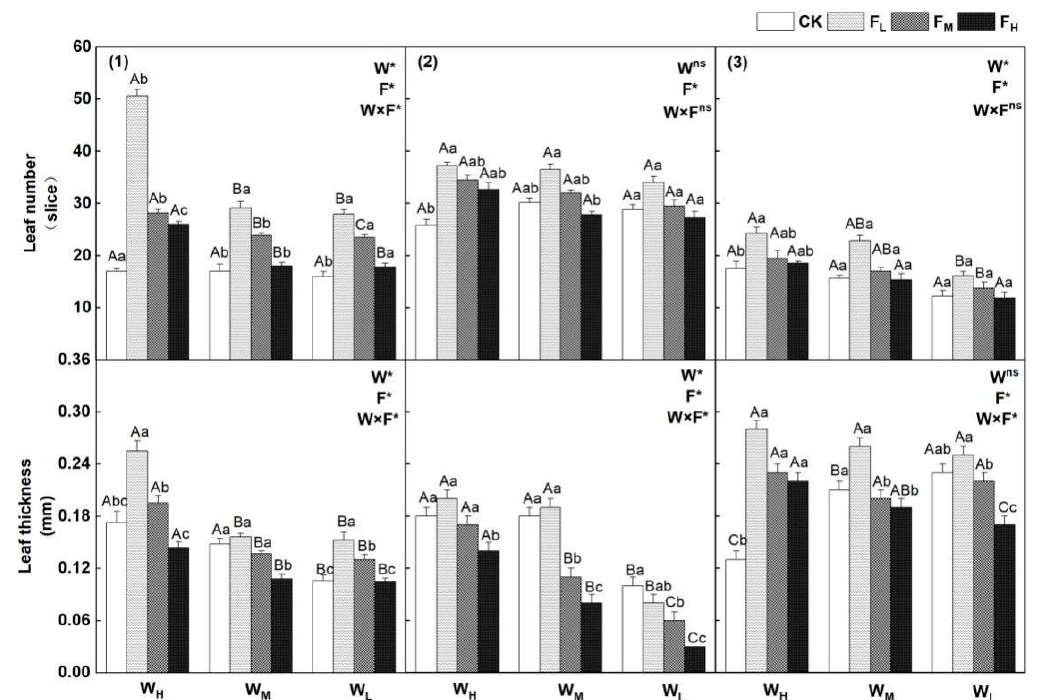
Figure 2. Changes in leaf number and leaf thickness values of test plant species under different water– fertilizer treatments. Numbers ( 1 ) − ( 3 ) in brackets indicate P. crymophila , F. coelestis , and S. purpurea , respectively. W, F, and W × F indicate the results of ANOVAs ( p < 0.05) for the effects of water, fertilizer, and their interactions. Asterisk (*) and ns indicate significant difference and non-significant. The uppercase letters and lowercase letters represent the difference between water and fertilizer treatments.